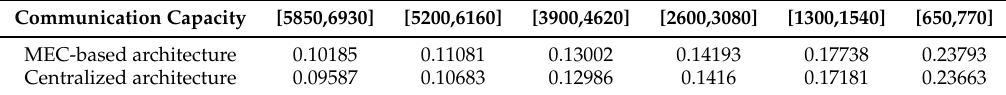
Figure 13. Time cost of the proposed algorithm under MEC-based and centralized architectures. Table 2. Estimation error comparison between MEC-based and centralized architectures.